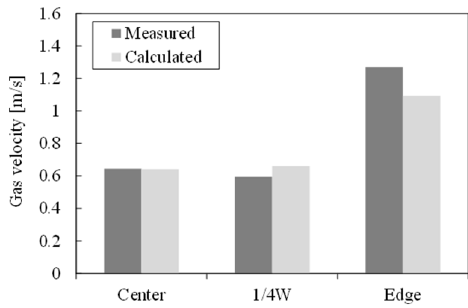
Figure 16. Comparison of gas velocity above packed bed in pilot-scale slag heat recovery chamber.